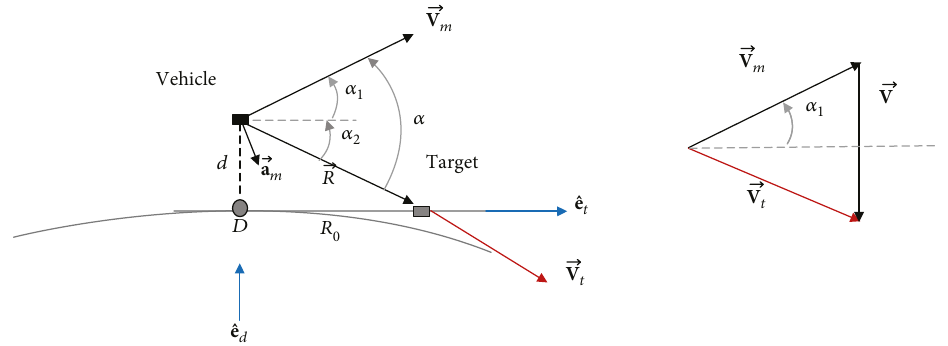
Figure 6: Linear model for circular path following.